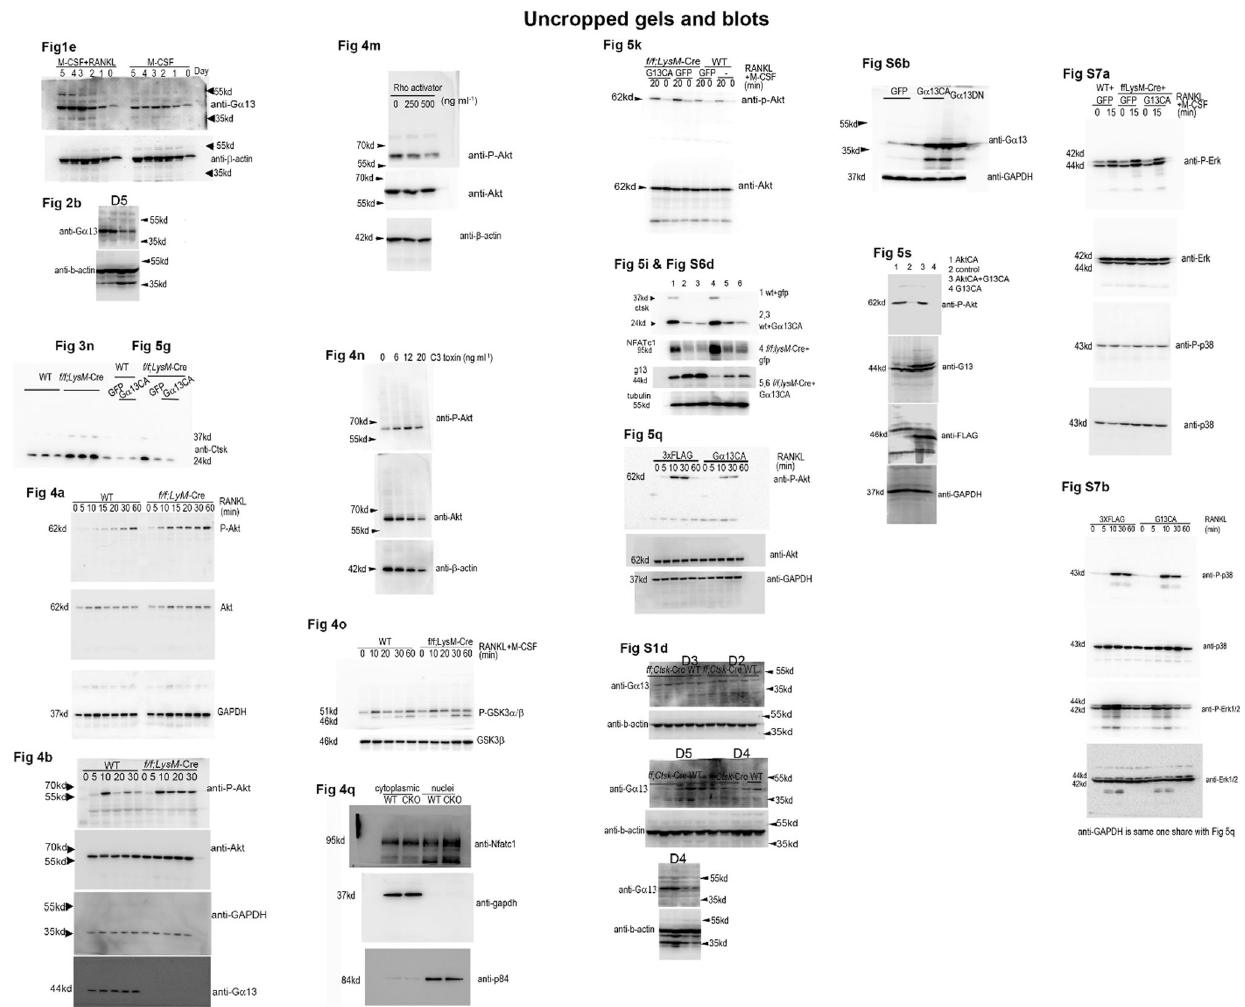
Fig. 5 Uncropped images for western